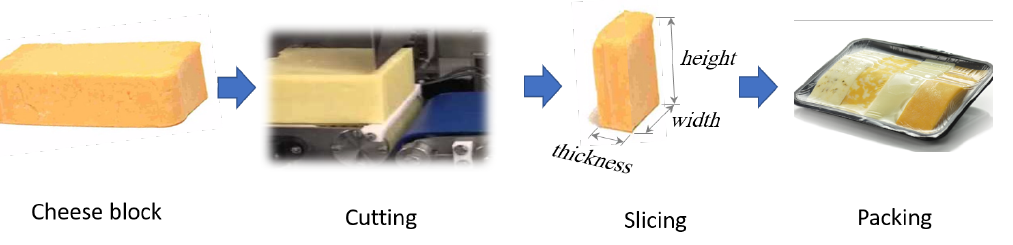
Figure 2. Cheese process.